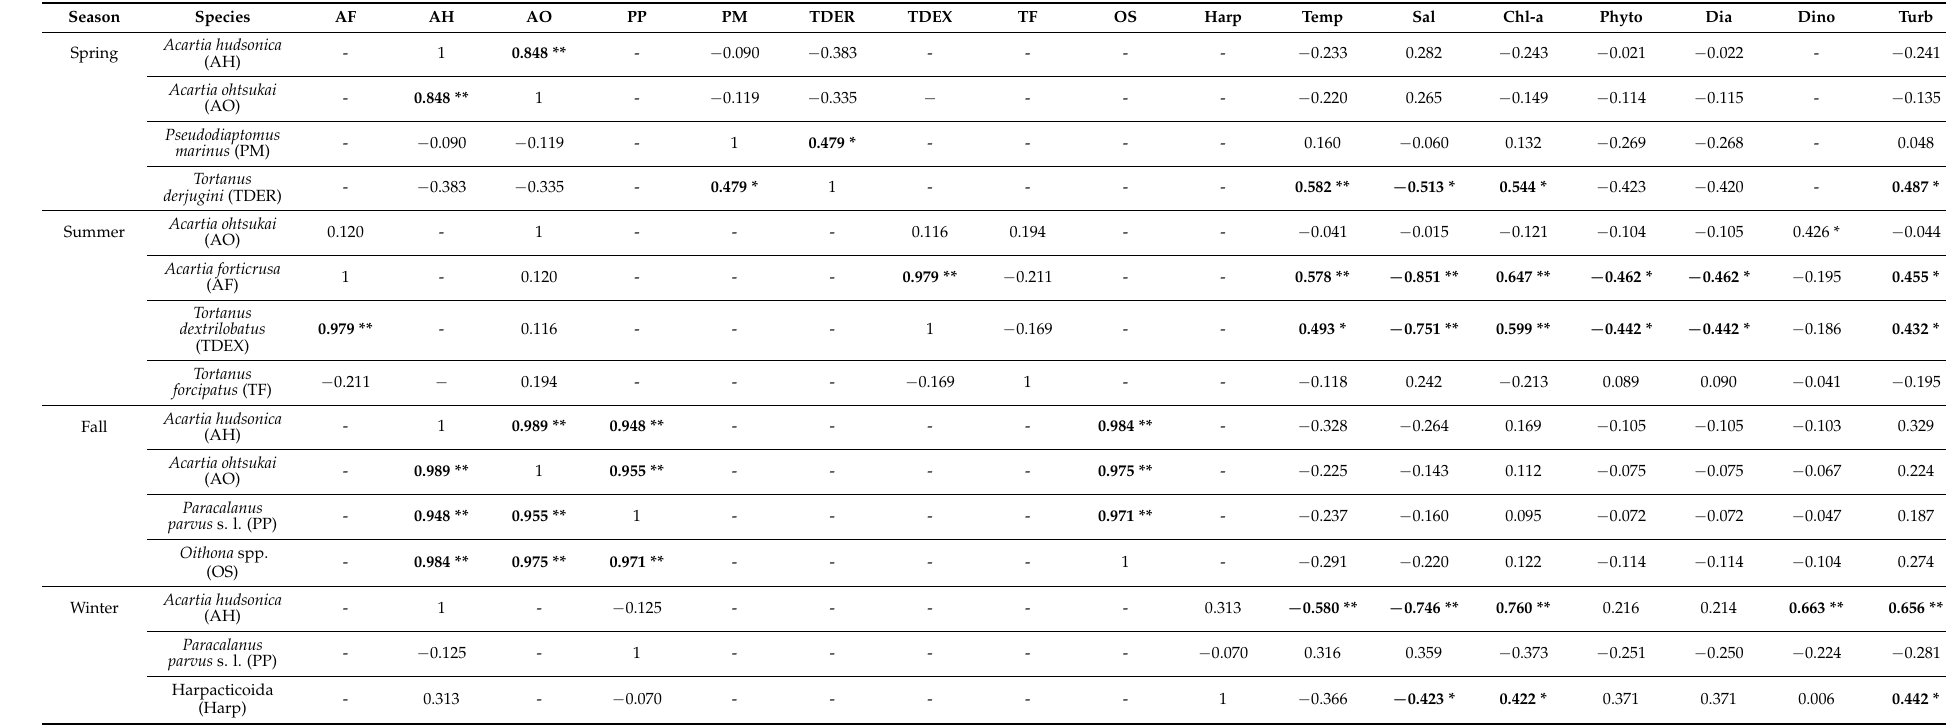
Table 2. Correlations between common species and environmental factors across different seasons in Doam Bay (sample size: 88; ** indicates p < 0.01; * indicates p < 0.05). Abbreviations: AF, Acartia forticrusa ; AH, Acartia hudsonica ; AO, Acartia ohtsukai ; PM, Pseudodiaptomus marinus ; PP, Paracalanus parvus s. l.; TDER, Tortanus derjugini ; TDEX, Tortanus dextrilobatus ; TF, Tortanus forcipatus ; OS, Oithona spp.; Harp, Harpacticoida; Temp, Temperature; Sal, Salinity; Phyto, Phytoplankton; Dia, Diatomeae; Dino, Dinoflagellata; Turb, Turbidity. Season Species AF